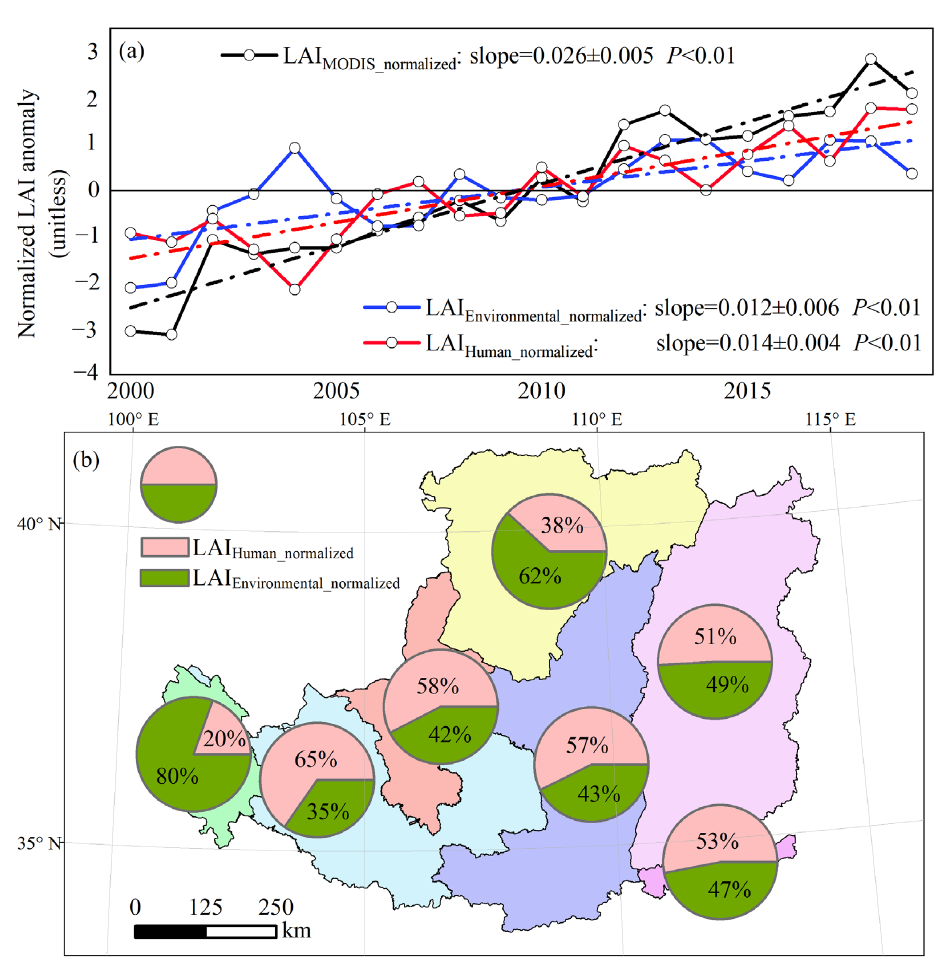
Figure 5. The influences of natural and anthropogenic factors on vegetation change in the Loess Plateau during 2000–2019. ( a ) The relative interannual trends of actual LAI (LAI MODIS_normalized ), environmental change-induced LAI (LAI Environmental_normalized ) and human land-use management-induced LAI (LAI Human_normalized ). Anomalies were calculated as the difference between the normalized LAI for a given year and the average value during the study period. ( b ) The relative contribution of environmental change and human land-use management to the actual LAI trends for each province.